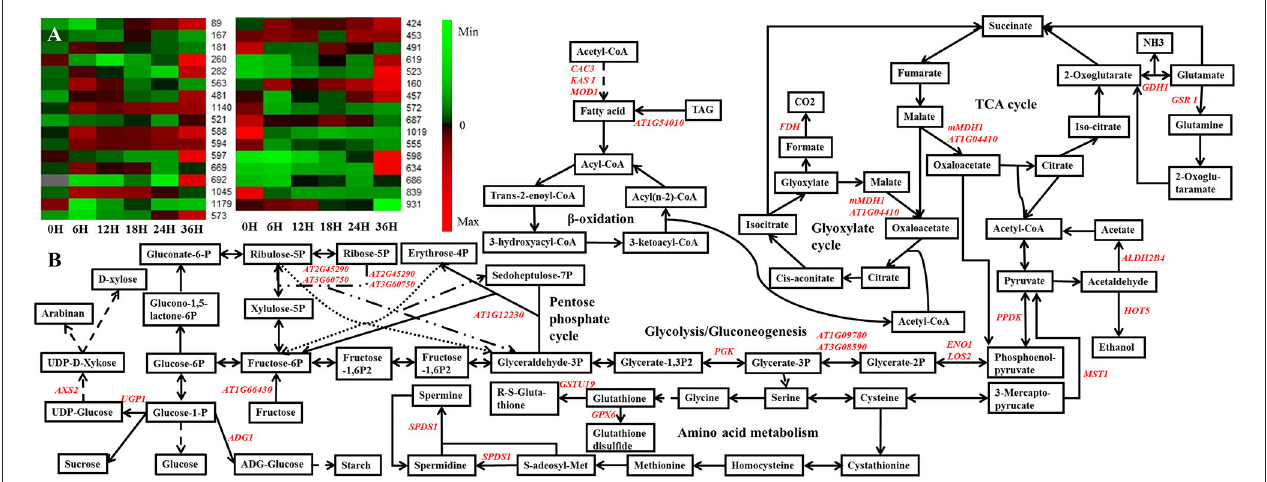
FIGURE 6 | The metabolic pathways based on the proteomic data. (A) The expression pattern of DEPs showed in the metabolic pathways. (B) the metabolic pathways. Gene symbol and corresponding DEP spot numbers are as follows: ADG1 , spot 491; ALDH2B4 , spot 1179; AT1G04410 , spot 1045; AT1G09780 , spot 260; AT1G12230 , spot 597; AT1G54010 , spot 572; AT1G66430 , spot 619; AT2G45290 , spot 167; AT3G08590 , spot 282; AT3G60750 , spot 181; AXS2 , spot 523; CAC3 , spot 160; ENO1 , spot 481; FDH , spot 573; GDH 1 , spot 555; GPX6 , spot 931; GSR 1 , spot 598; GSTU19 , spot 839; HOT5 , spot 521 and 563; KAS I , spot 457; LOS2 , spot 1140; mMDH1 , spot 669 and 692; MOD1 , spot 687 and 1019; MST1 , spot 686; PGK , spot 588 and 594; PPDK , spot 89; SPDS1 , spot 634; UGP1 , spot 424 and